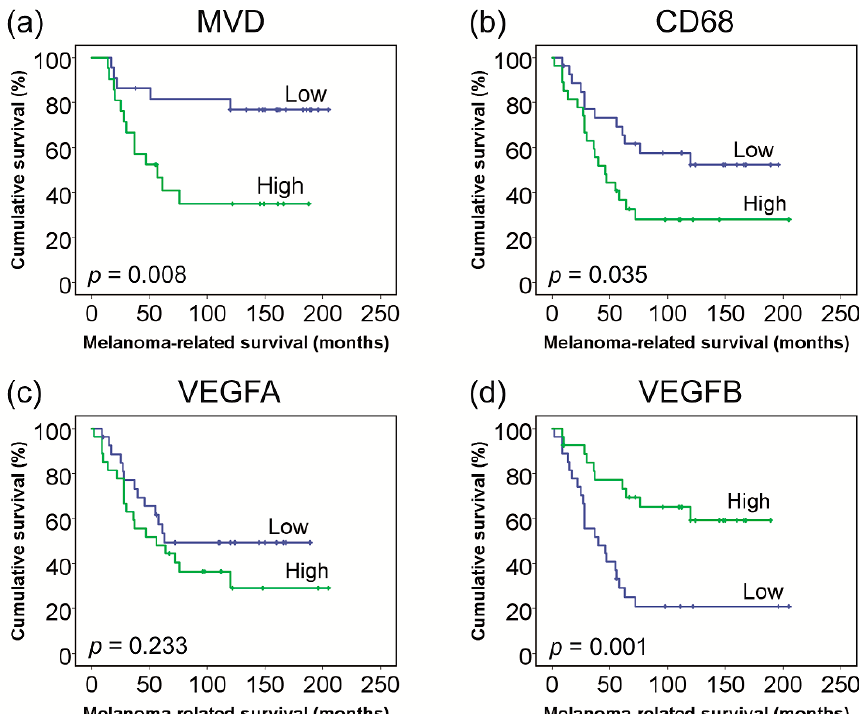
Figure 1. Patient survival in relation to MVD and mRNA gene expression. Groups (high vs. low) were